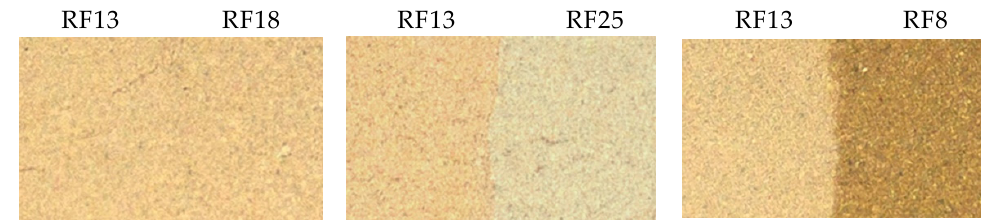
Figure 8. Comparison of the RF samples by color.